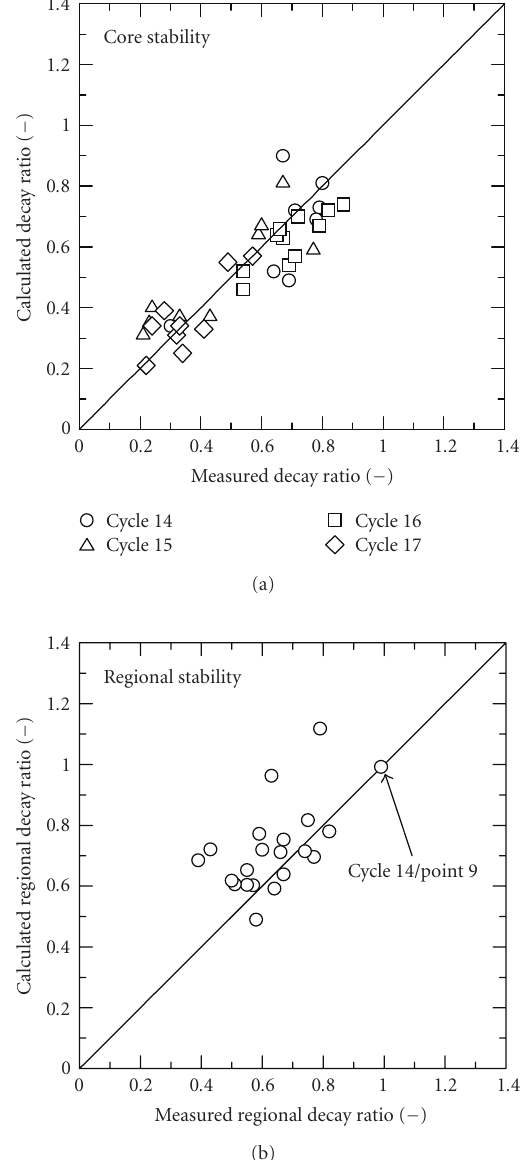
Figure 6: Sample of verification for the time-domain code using Ringhals-1 stability test